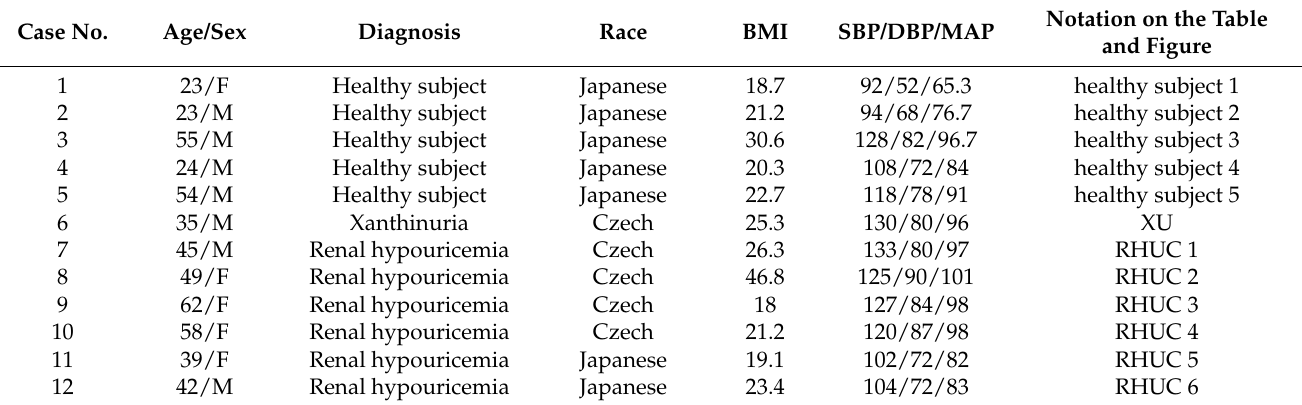
Table 1. Characteristics of the 12 subjects with semi-ischemic forearm exercise